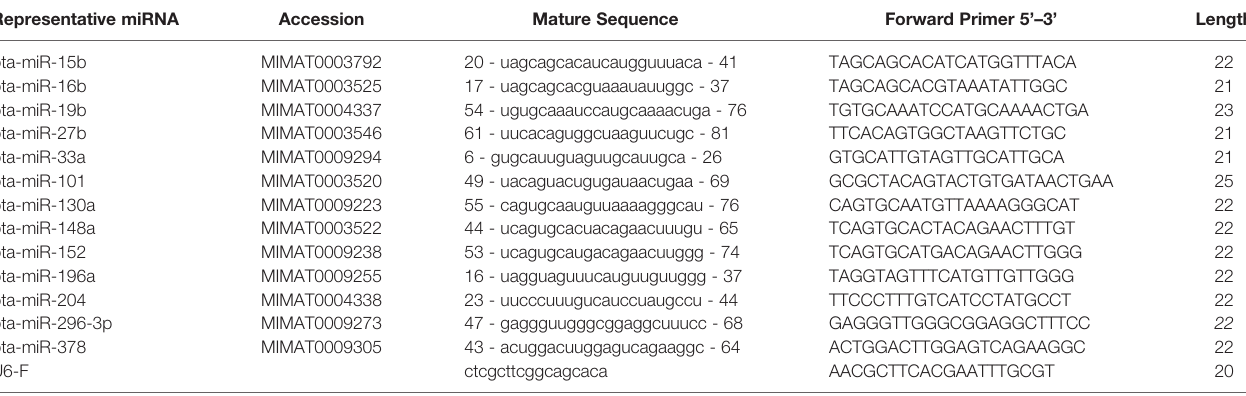
TABLE 2 | Primer sequences for miRNA expression measured by real-time